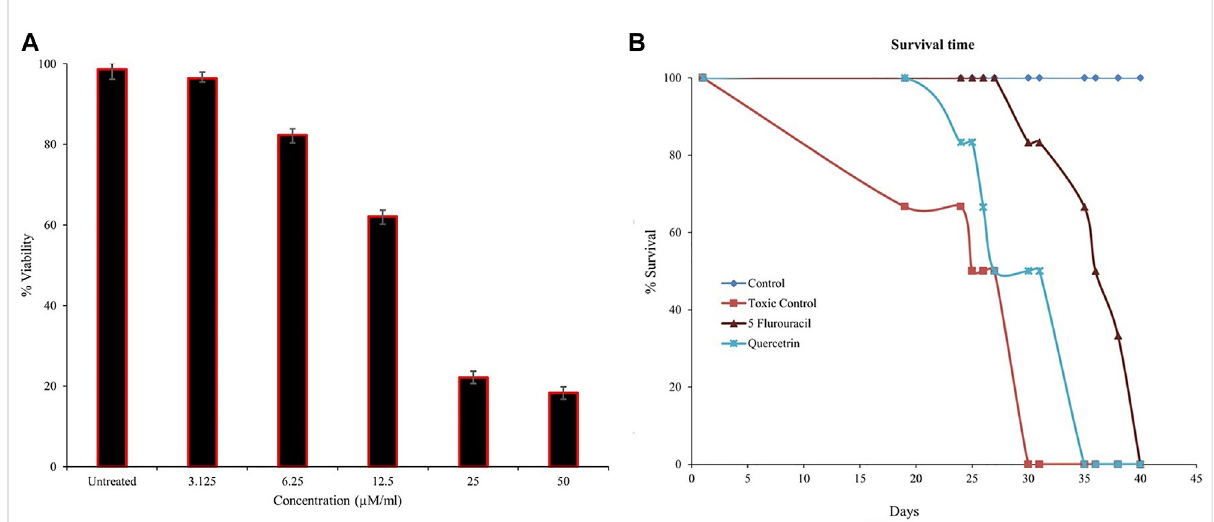
FIGURE 6 Estimation of cell viability and mean survival time (MST). (A) Quercitrin in the range of 0 – 50 µM concentration reduced PC3 cell viability in a dose-dependent manner and the IC 50 value was found to be 12.26 μ M ± 0.9. (B) The graph shows the increased mean survival time of mice bearing Ehrlich ascitescarcinomatumorcells ontreatment with quercitrinand standard 5- fl uorouracil.The dataare expressed inmean± standarddeviation ( n = 3)